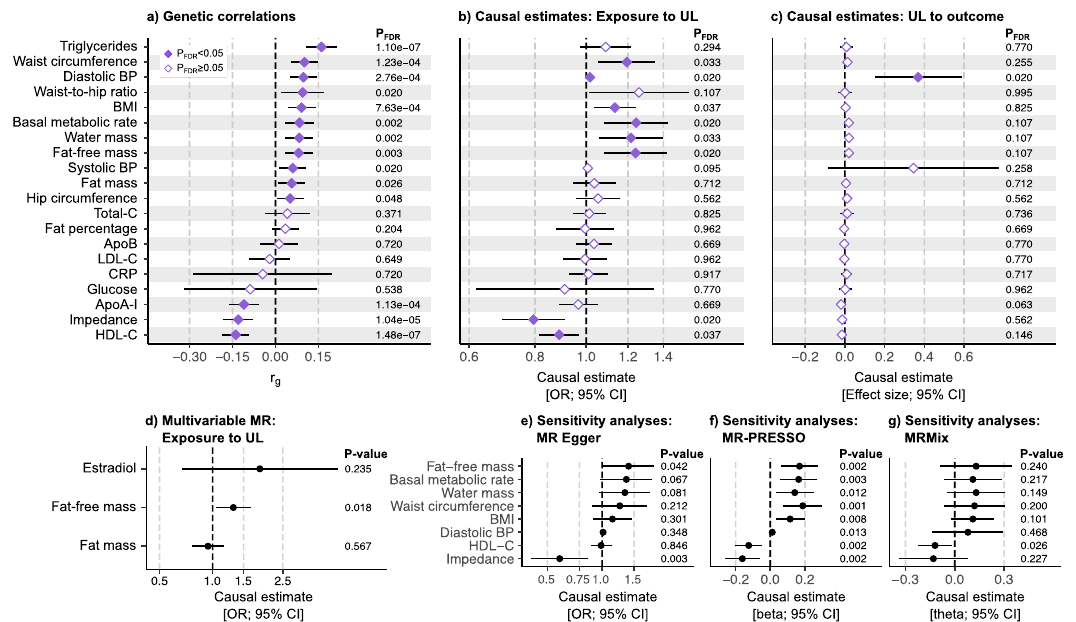
Fig. 5 | Genetic correlations and causal relationships between uterine leio- myomata and metabolic and anthropometric traits. We estimated a genetic correlations ( r g ) between uterine leiomyomata (UL) and 20 metabolic and anthropometric traits using UL-GWAS data from META-2 ( n =367,903) and sum- mary statistics for other traits as provided by the MRC Integrative Epidemiology Unit (IEU) GWAS database ( n ranges from 33,231 to 757,601; the trait-speci fi c samplesizesareprovidedinTableS11).TheanalysissoftwarewasLDSC 21 .Todissect the causal relationships, we performed bi-directional two-sample Mendelian ran- domisation (MR) implemented in the TwoSampleMR R library 60,63 ; the plots ( b , c ) show the causal estimates obtained using the inverse variance-weighted (IVW) method. We further estimated d the multivariable effects of whole-body fat-free mass, whole-body fat mass, and estradiol level on UL risk using the same Two- SampleMR R library 60,63 . In sensitivity analyses, we derived causal estimates